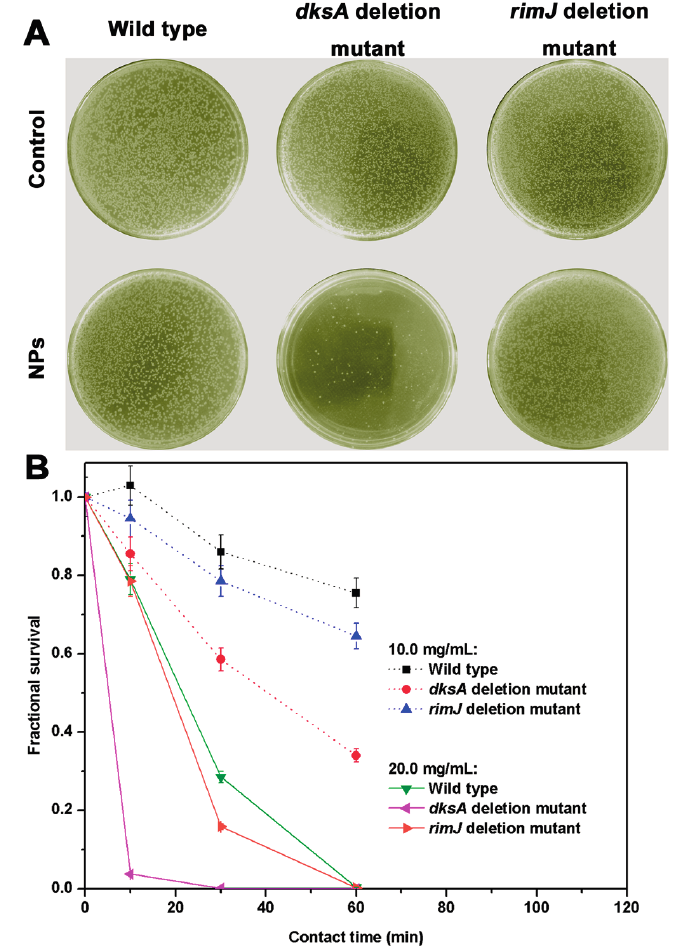
Figure 6. ( A ) Photographs showing the bacterial culture plates of the wildtype E. coli , dksA deletion mutant strain, and rimJ deletion mutant strain treated with the control and SiO 2 @PS/ N -halamine NPs with concentration of 20.0 mg/mL for 10 min; ( B ) Time-kill assay curve of the wildtype E. coli , dksA deletion mutant strain, and rimJ deletion mutant strain treated with the SiO 2 @PS/ N -halamine NPs with two different sample concentrations (10.0 mg/mL and 20.0